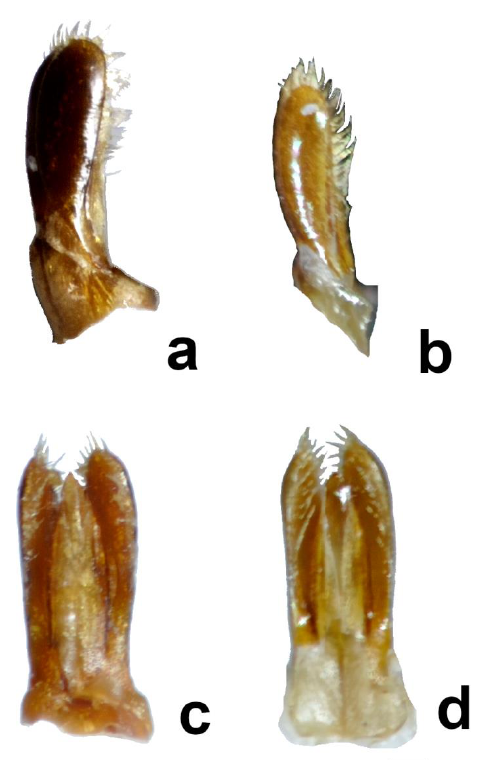
Figure 3. Chilocorus renipustulatus , male genitalia: parameres and penis guide. ( a , c ) Male from Germany; ( b , d ) male from Japan, Honshu; ( a , b ) lateral view, ( c , d ) ventral view. Scale bar: 0.1 mm.